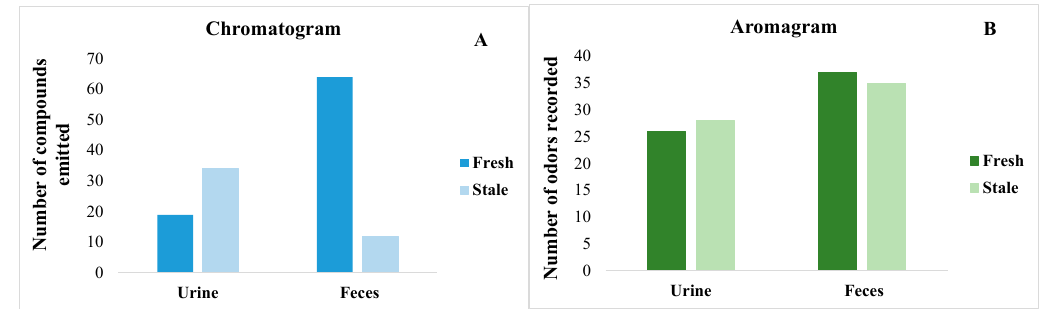
Figure 1. Comparison of the number of compounds detected in the headspace of fresh/stale urine and feces using GC–MS analysis (( A ) chromatogram) and GC–MS–olfactometry analysis (( B ) aromagram): the solid-phase microextraction (SPME) fiber was exposed for 50 min at 37 °C.